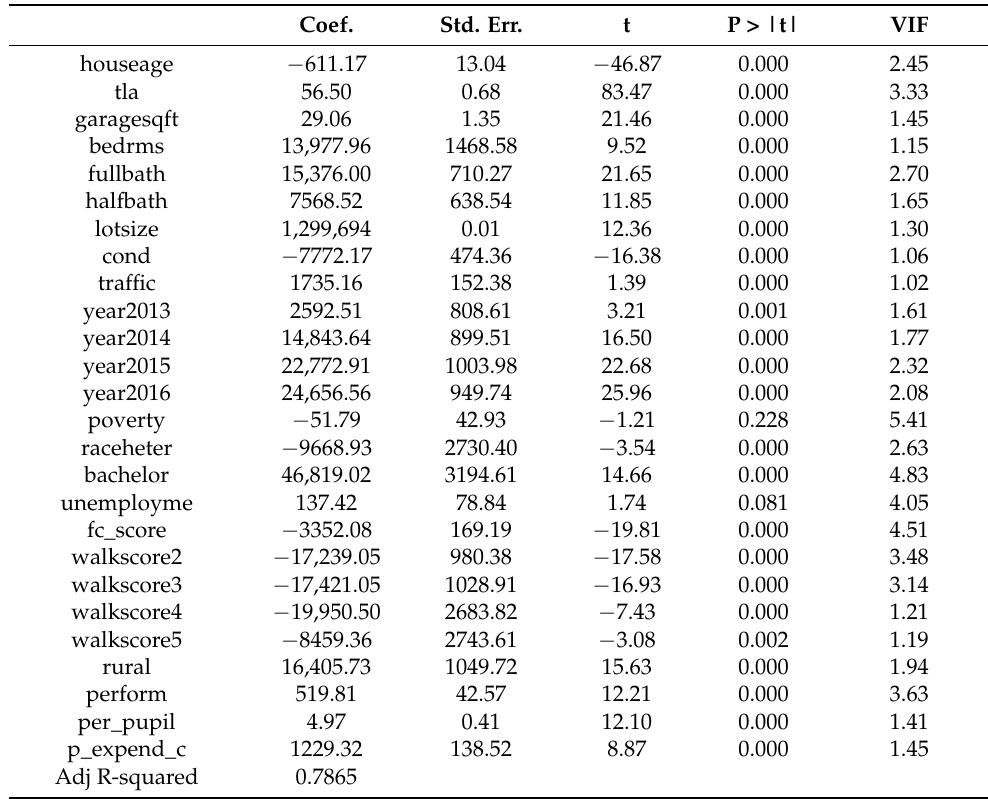
Table 7. Results of ordinary least squares regression.